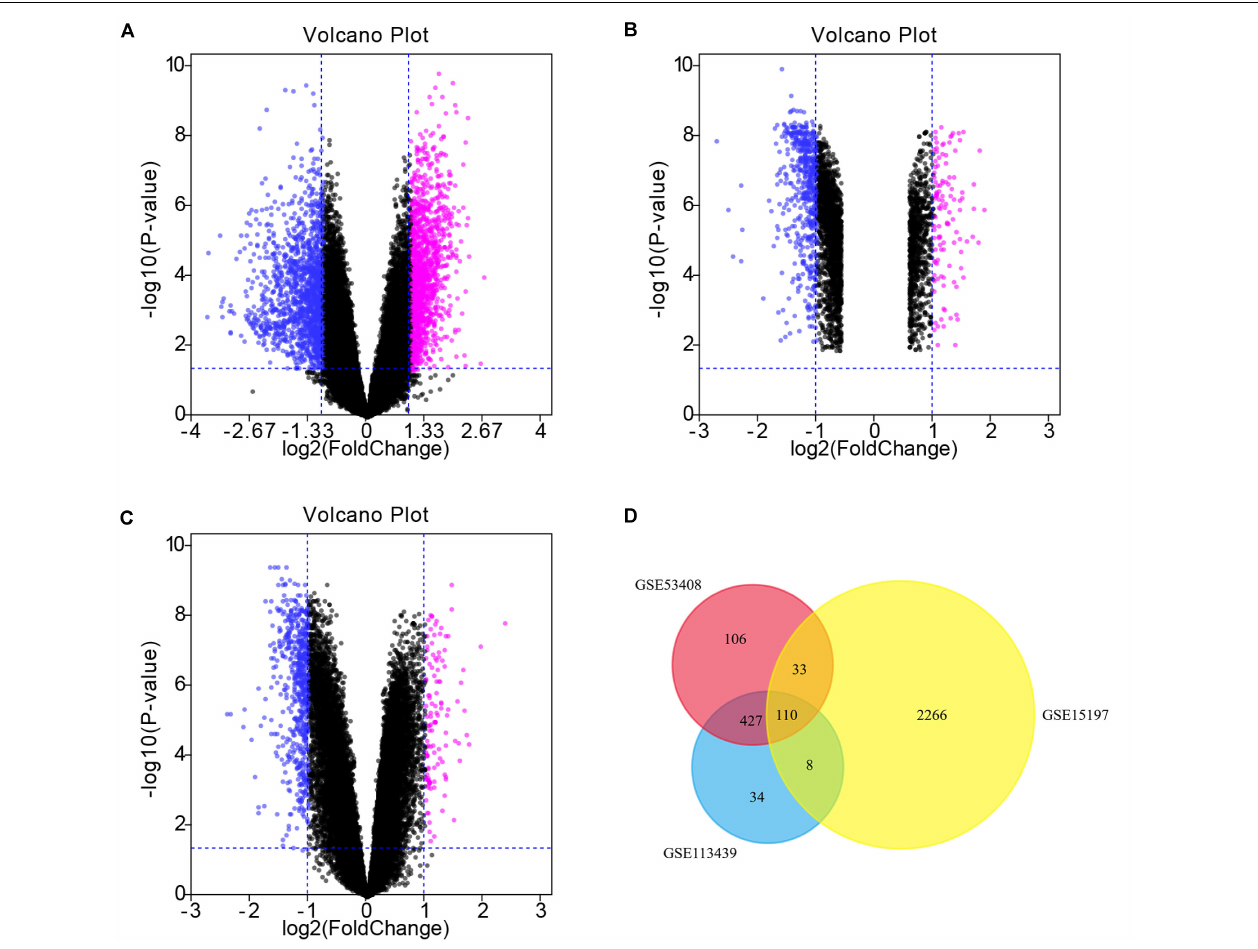
FIGURE 4 | Volcano plots and Venn diagram. (A–C) DEGs were selected with |log2FC| > 1 and adj. P -value < 0.05 among the mRNA expression profiling sets GSE15197 (A) , GSE53408 (B) , GSE113439 (C) . Each symbol represents a different gene in the volcano plot. Pink symbols represent upregulated genes; blue symbols represent downregulated genes. (D) There were 676, 579, and 2417 DEGs obtained from the GSE53408, GSE113439, and GSE15197 datasets, respectively. The 3 datasets showed an overlap of 110 genes in the Venn